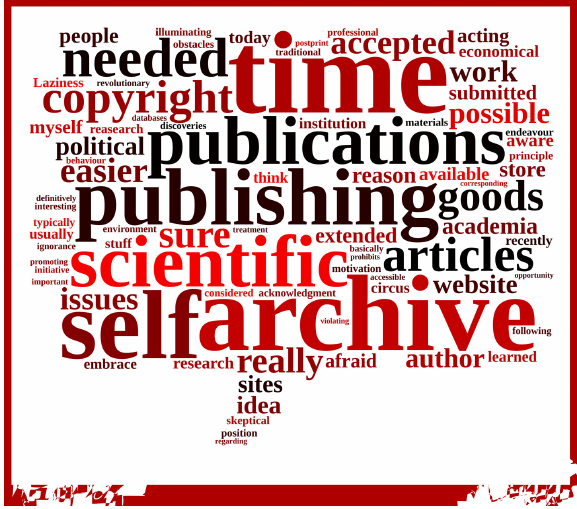
Figure 6. A word cloud of the 100 most frequent words pro- vided by the